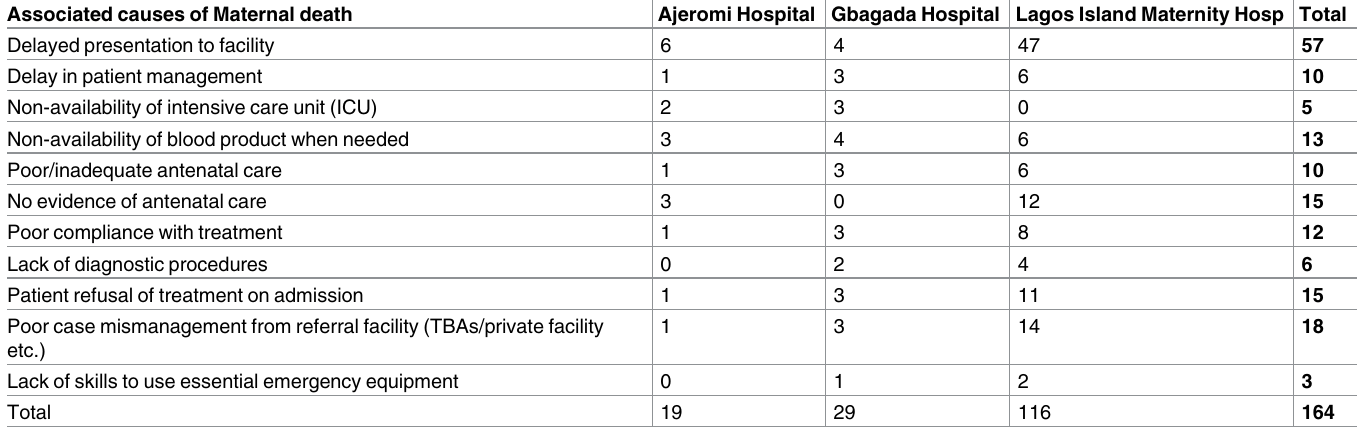
Table 4. The major identified associated causes of maternal deaths in the